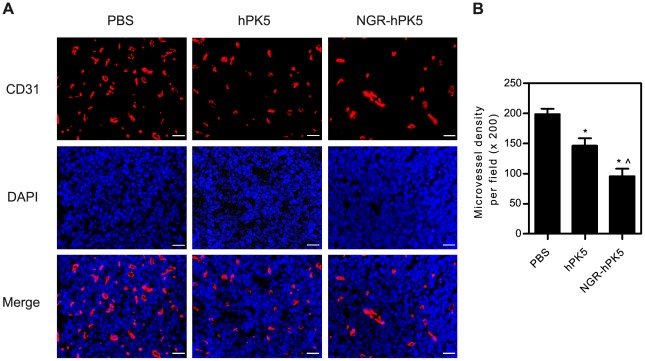
Immunofluorescence analysis of neovascularization in tumors.LLC tumor-bearing C57BL6/J mice were systemically treated with control saline or with 2.5 mg/kg/day of hPK5 or NGR-hPK5 daily for 5 days, and primary tumors were resected on day 1 after post-treatment. A
, The immunofluorescence analysis was evaluated for visualization of CD31-positive endothelial cells. DAPI counterstain was used to visualize nuclear detail. B
, Microvessel density per field (×200) of experimental group and saline-treated group. The data shown were the mean ± SD. Microvessels were counted from three most vascular areas (‘hot spots’) fields in tumors from three mice in each group. Bar = 20 µm, * p<0.05 compared with control, ∧ p<0.05 compared with hPK5.